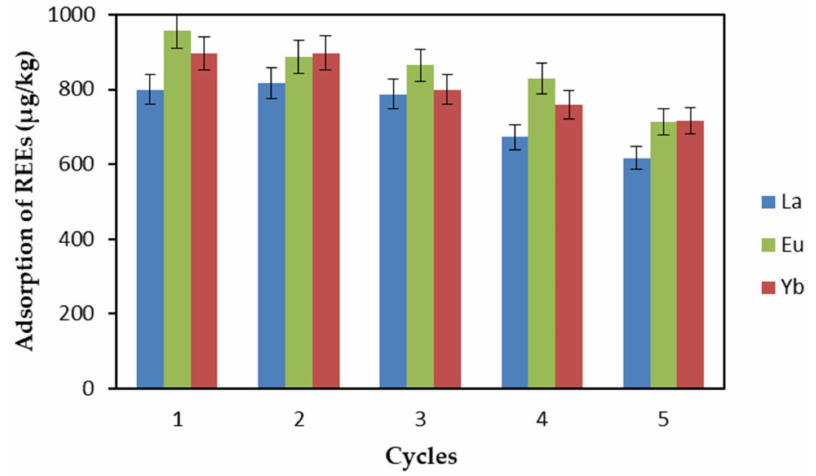
Figure 14. Recycled adsorption of REEs by